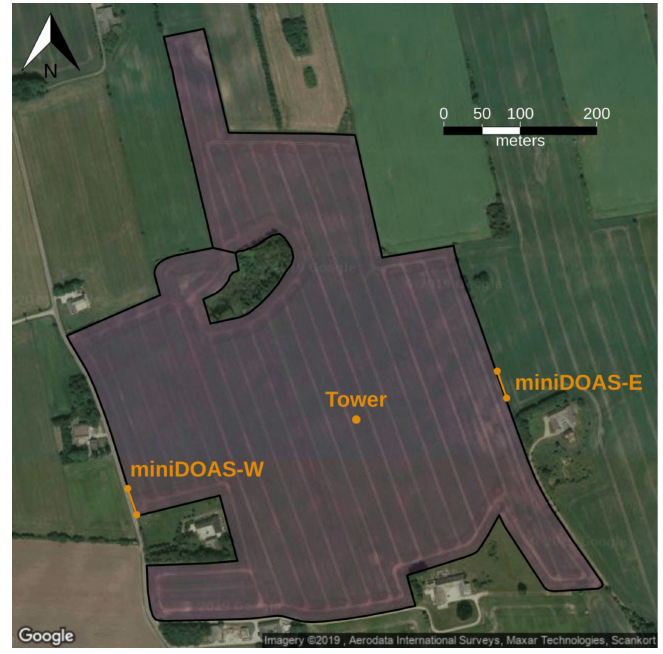
Figure 1. Overview of the field and measurement location on the field. The colored area is the 26-ha field where slurry was applied. MD-W and MD-E are the differential optical absorption spec- troscopy (miniDOAS) located west and east, respectively, the tower includes the micrometeorological measurements and point concentration measurement of ammonia (NH 3 ) with cavity ring-down spectroscopy